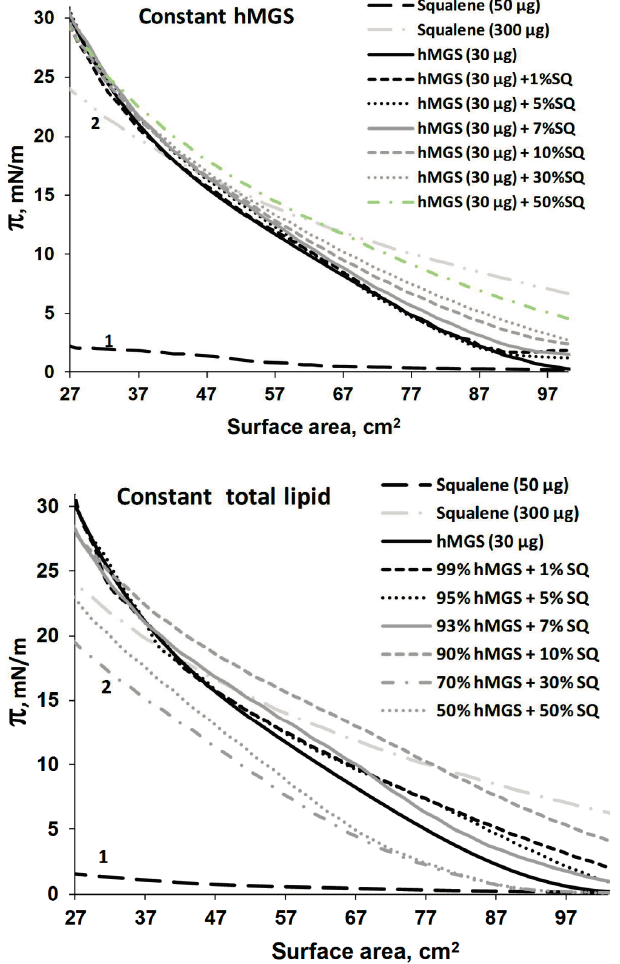
Figure 4. Compression π (A)-isotherms of hMGS, squalene (curve 1 and 2–50 and 300 µg SQ deposited at the trough surface respectively) and SQ/hMGS mixtures. The weight percentage of squalene is shown on the figure legends. Upper panel displays compression isotherms when the amount of total lipid (=hMGS + SQ) on the surface is kept constant and the hMGS/SQ ratio is varied within this fixed total lipid quantity; and Bottom panel shows compression isotherms when the hMGS amount is kept constant, and the addition of SQ increases the total lipid amount on the